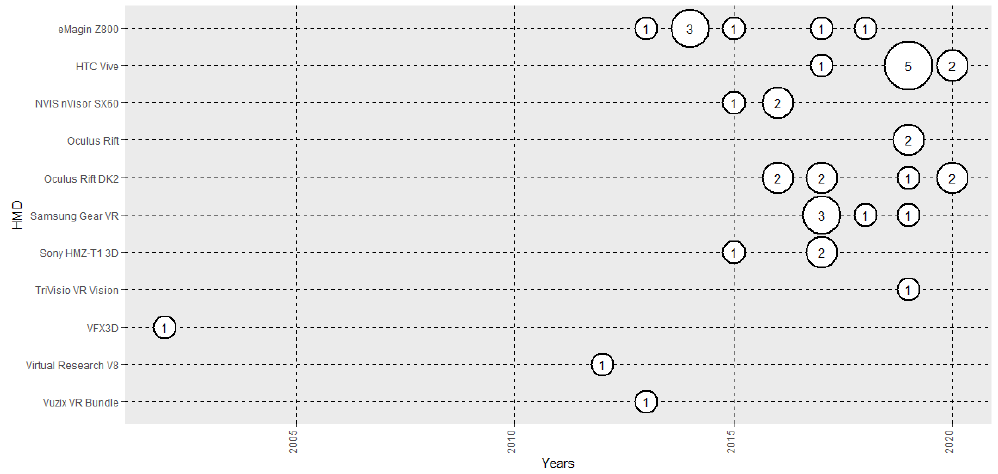
Figure 6. Evolution of the number of papers published each year based on head-mounted display (HMD) used.